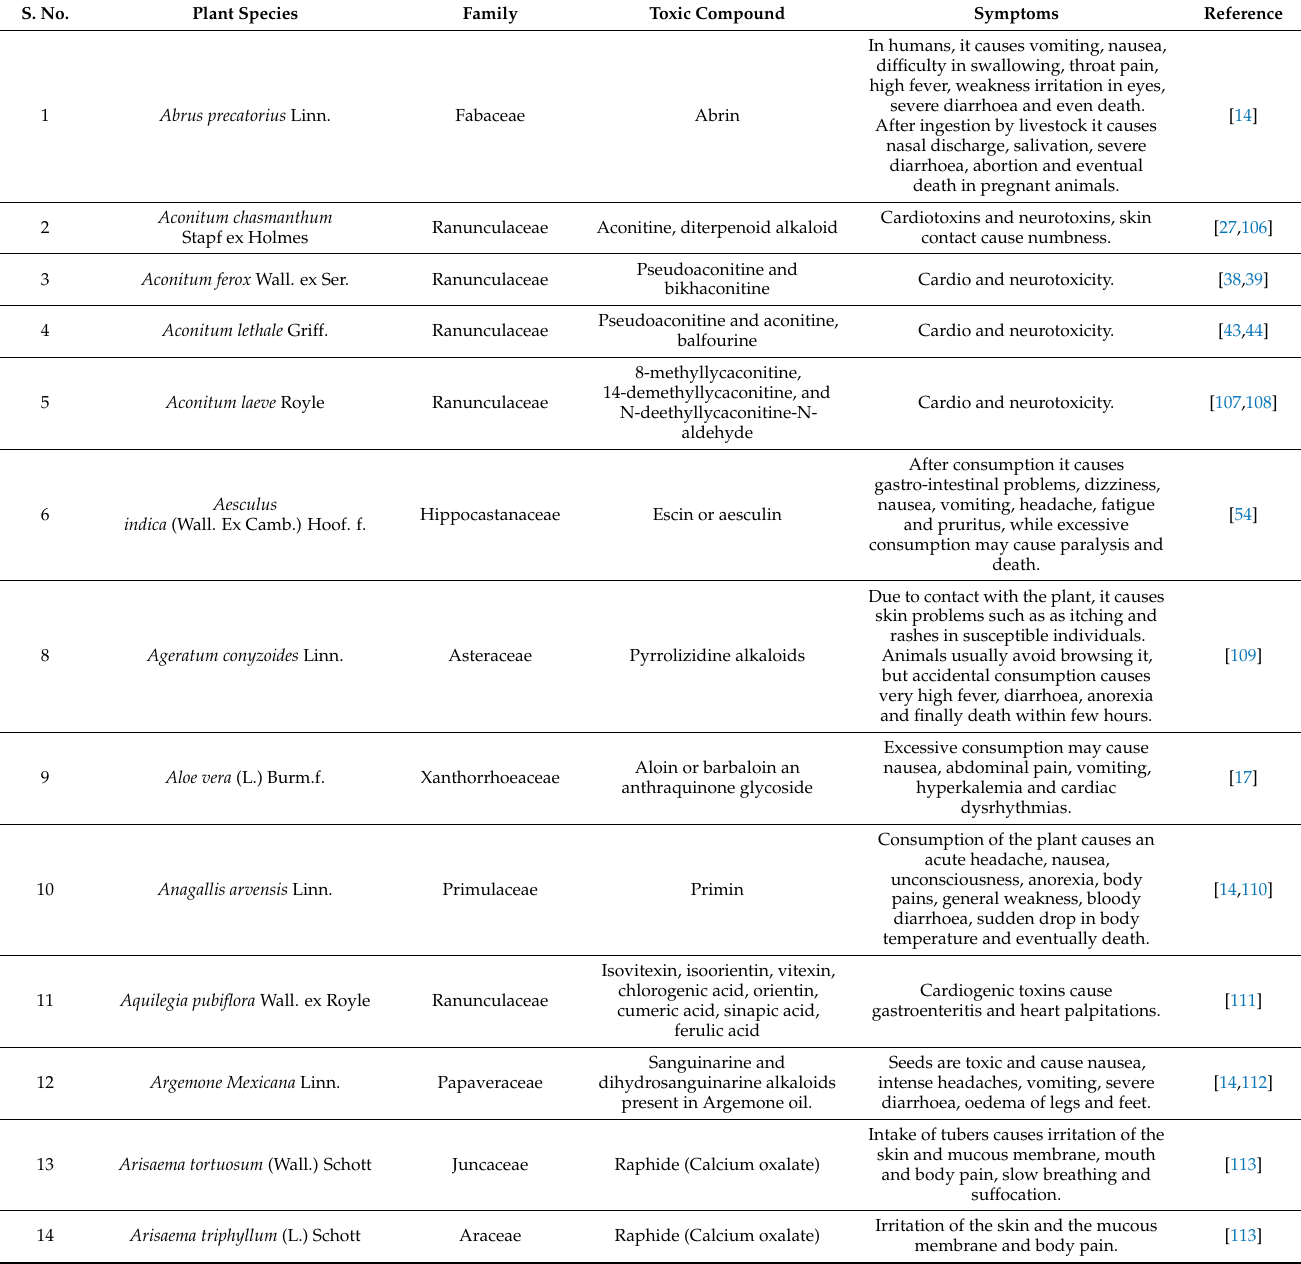
Table 1. Poisonous plants of Indian